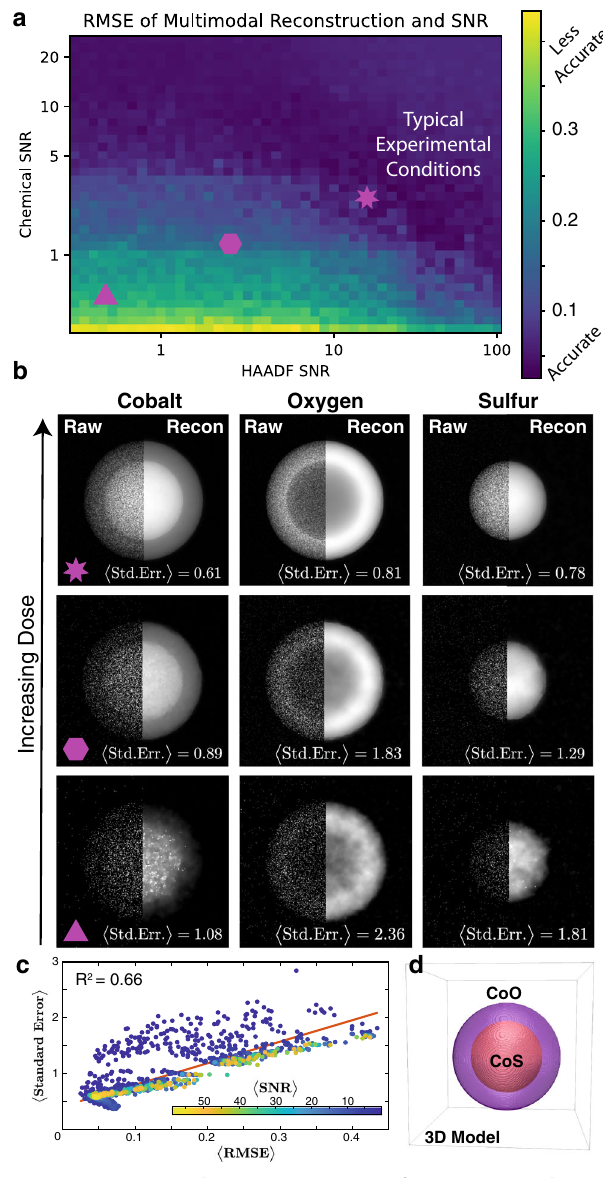
Fig. 6 Estimating dose requirements for accurate chemical recovery. a A RMSE map representing the reconstruction error as a function of multiple spectroscopic and HAADF SNR. Brighter pixels denote results containing the incorrect concentrations from the ground truth. b Visualization of three points on the phase diagram corresponding to increasing ADF/chemical electron dose. c A plot of average standard error vs. RMSE demonstrating the two metrics are linearly correlated. d The 3D model for generating synthetic chemical and ADF